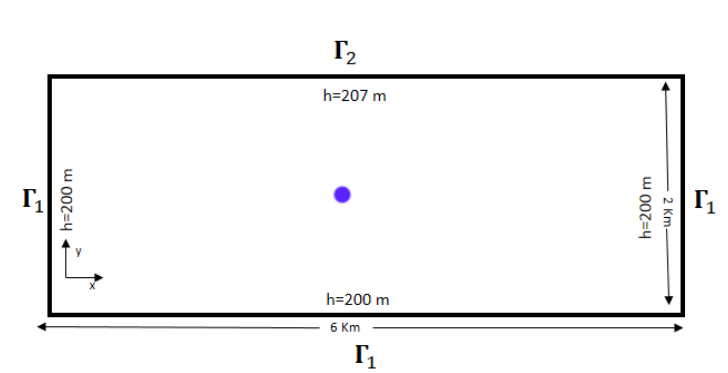
Figure 5. Schematic domain with boundary conditions.